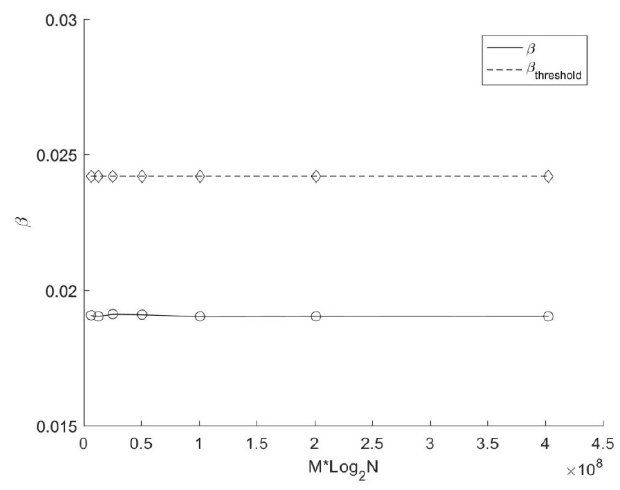
Figure 9. Variation of β and β threshold with different number of target points.